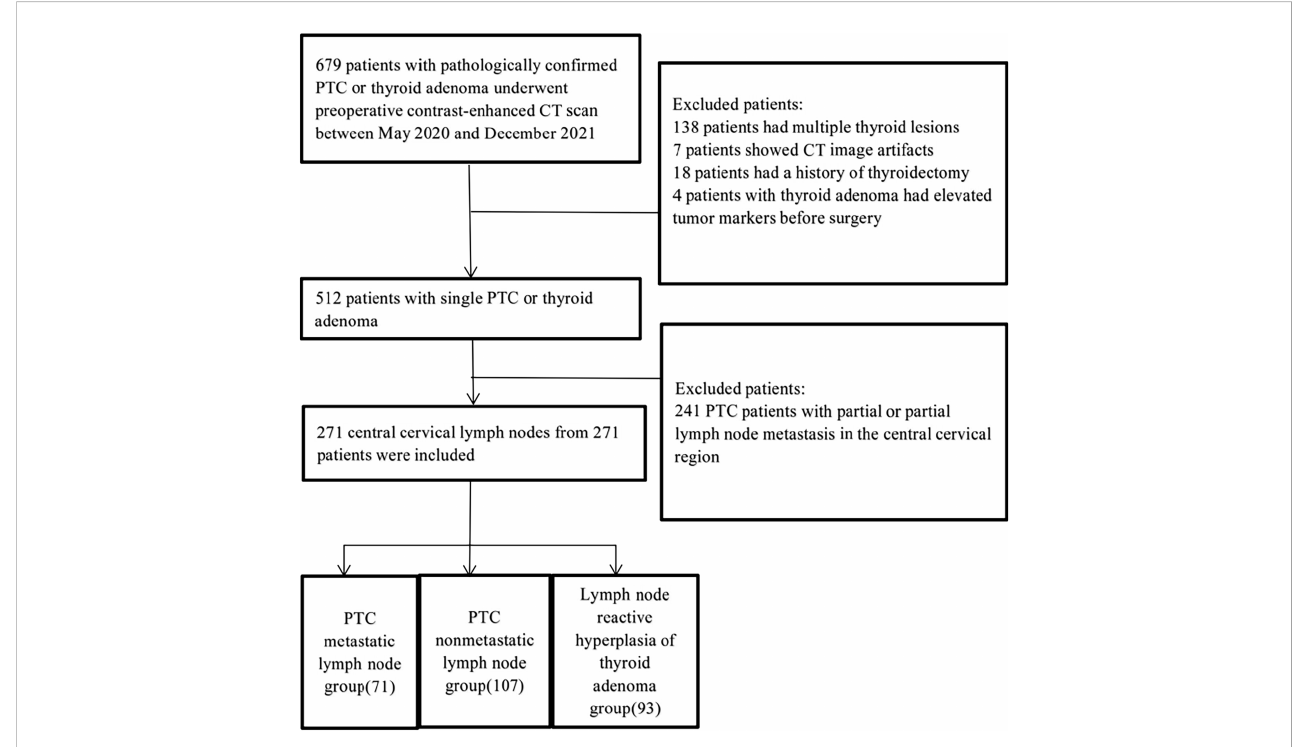
FIGURE 1 Patient enrollment